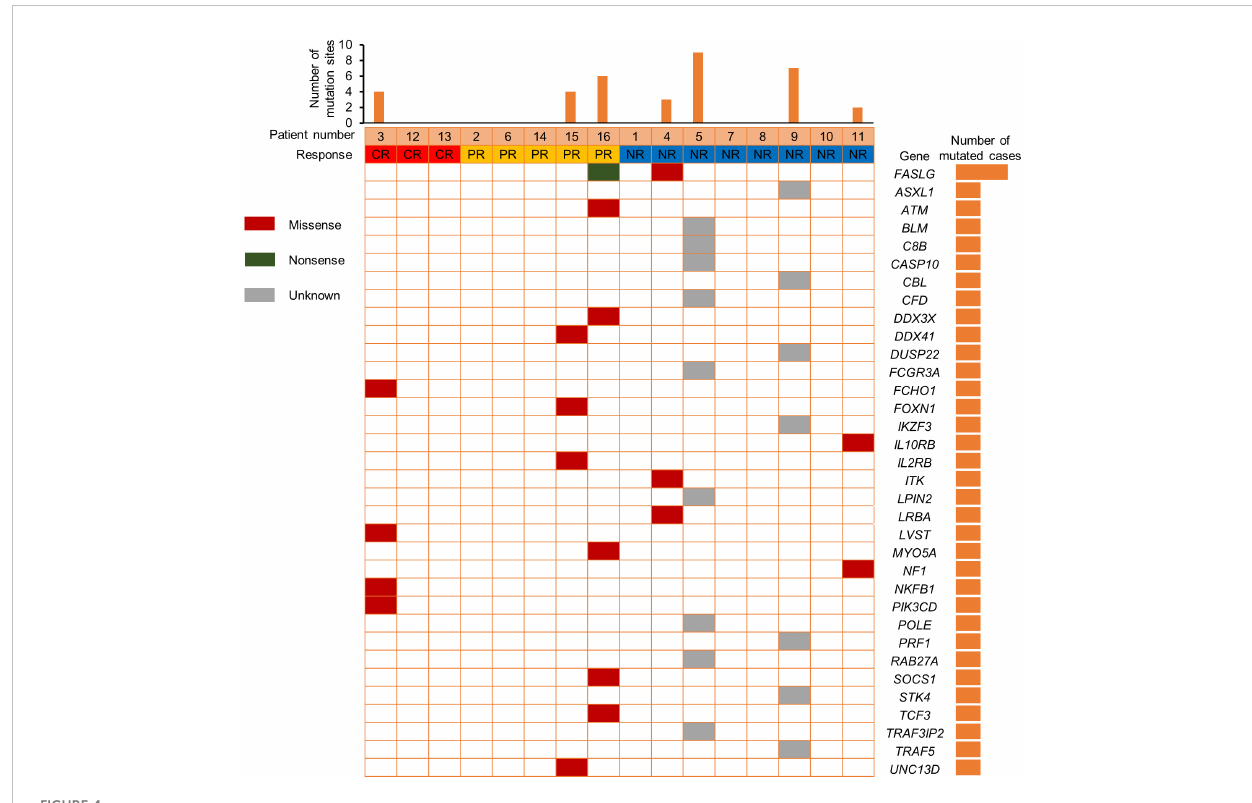
FIGURE 4 Comparison of mutation pro fi les according to